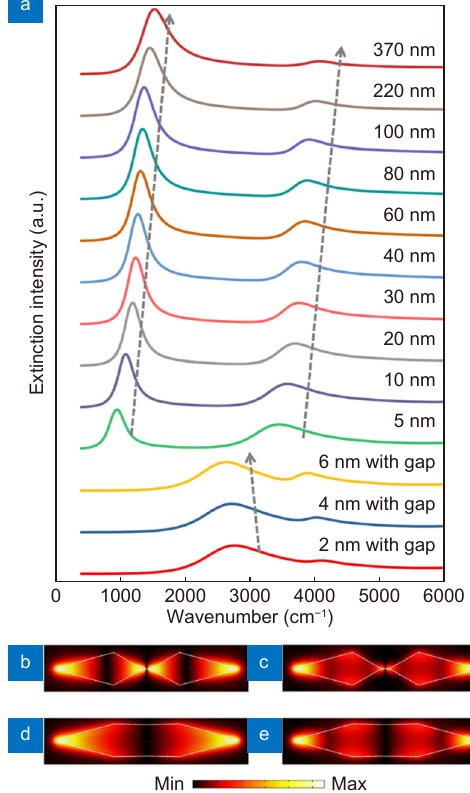
Fig. 3 | ( a ) Simulated extinction spectra of NBRA structure with dif- ferent nanobridge width. ( b – c ) Simulated mapping of | E z | of bonding dipolar plasmonic band (b) and bonding quadrupolar plasmonic band (c) of a single NBRA structure with a broken nanobridge and 4 nm gap size. ( d – e ) Simulated mapping of | E z | at CTP band (d) and BDP band (e) with 370 nm nanobridge